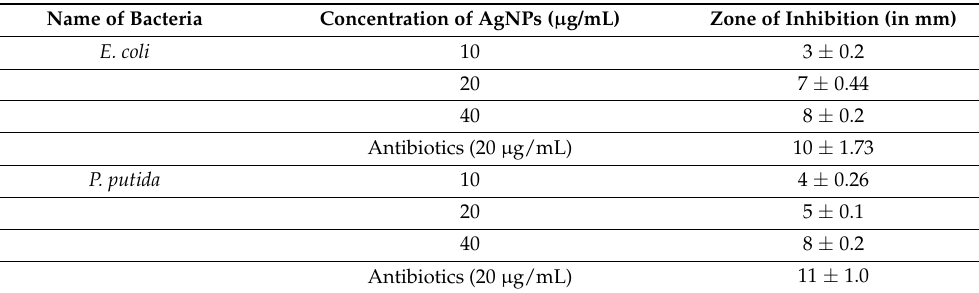
Table 4. Antimicrobial effect of AgNPs in Escherichia coli and Pseudomonas putida . Name of